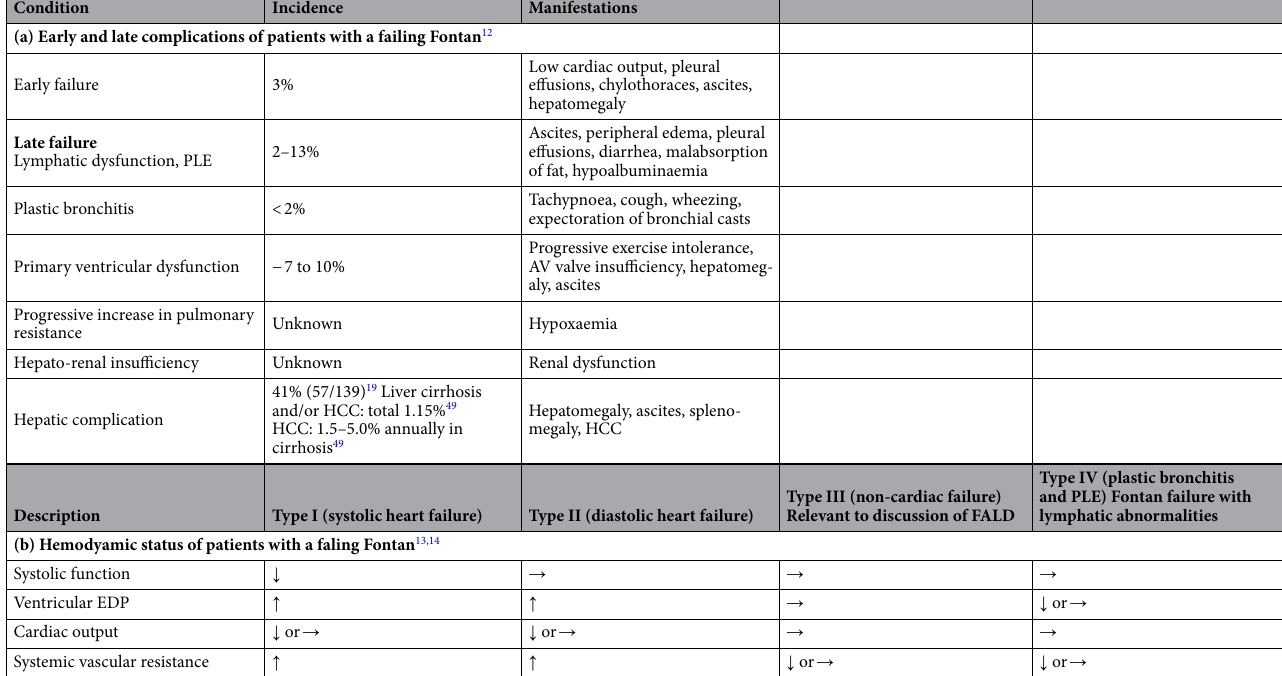
Table 1. Phenotypes of patients with a failing Fontan. AV atrioventricular, EDP end-diastolic pressure, HCC hepatocellular carcinoma, FALD Fontan-associated liver disease, PLE protein-losing enteropathy.